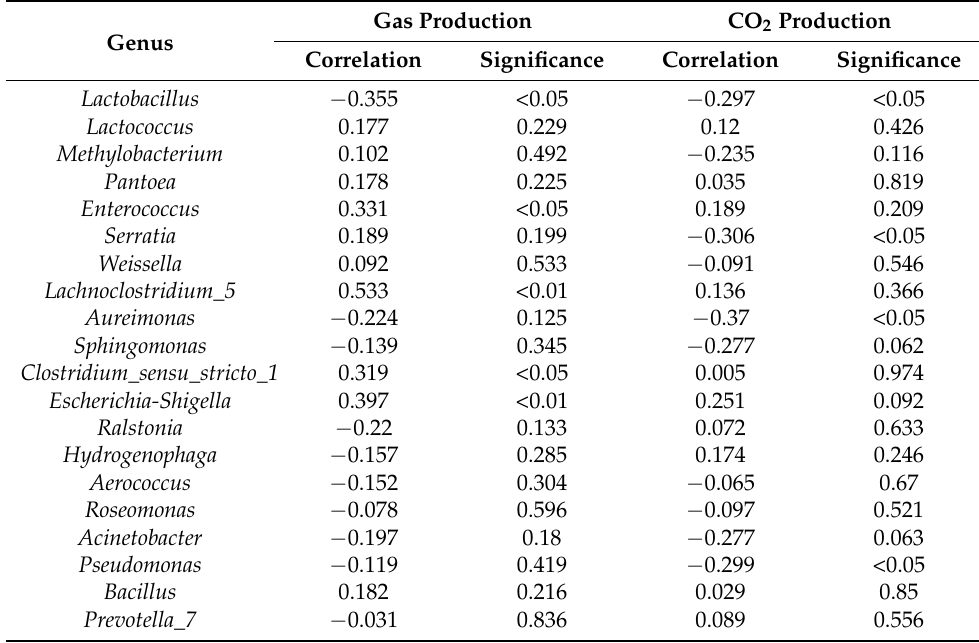
Figure 2. Relative abundance of bacterial communities by phylum ( A ) and genus ( B ) for B. papyrifera leaves silage (days 3, 7, 14, 30) treated with LP inoculant and stored at 15 °C (T1) and at 30 °C (T2). BPL, B. papyrifera leaves; CK, the control; LP, Lactobacillus plantarum; D3, D7, D14, D30, after 3, 7, 14, 30 days ensiling, respectively. Table 4. Correlation and significance analysis of gas production, CO 2 production and bacterial community of B. papyrifera leaves